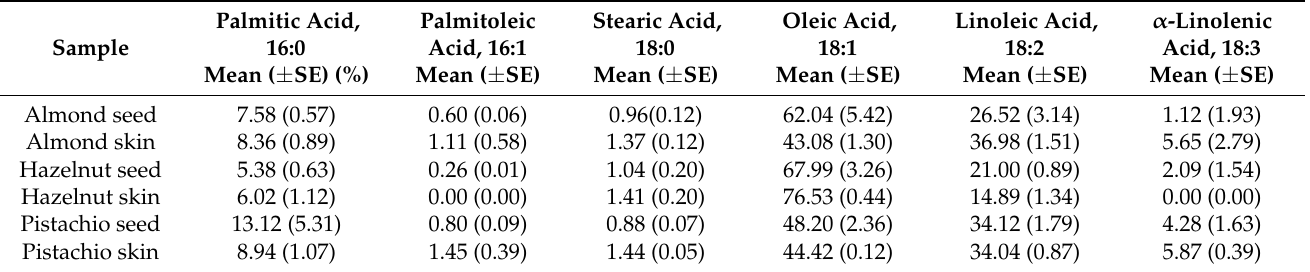
Table 3. The mean percentages of fatty acid content in 100 g of almonds, hazelnuts, and